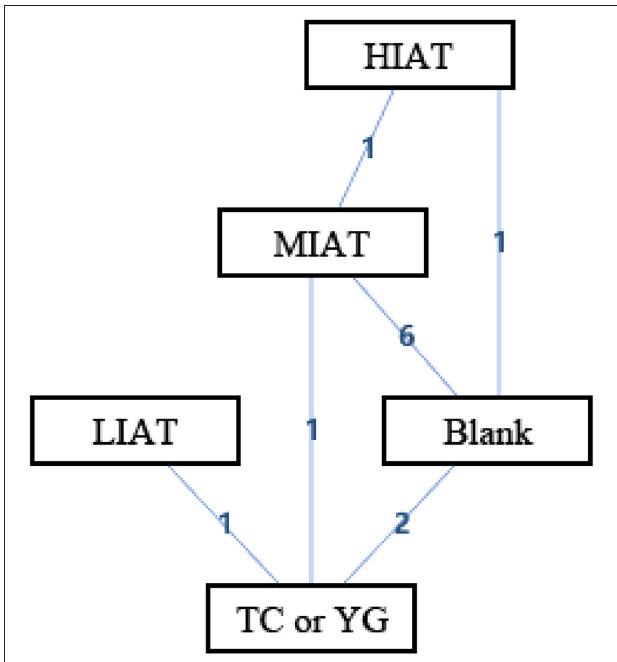
FIGURE 3 | The network structure of intervention of malondialdehyde (MDA). Blank, Blank control; HIAT, High intensity aerobic training; MIAT, Medium intensity aerobic training; LIAT, Low intensity aerobic training; TC or YG, Tai Chi or Yoga. The numbers on lines represent the number of studies that make direct comparisons between interventions.